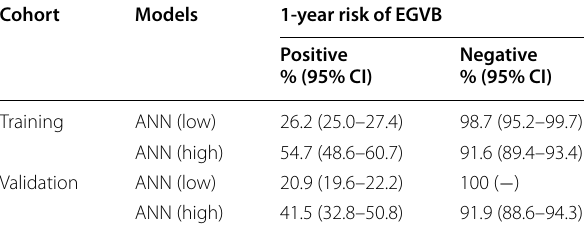
Table 2 Positive and negative predictive values of the